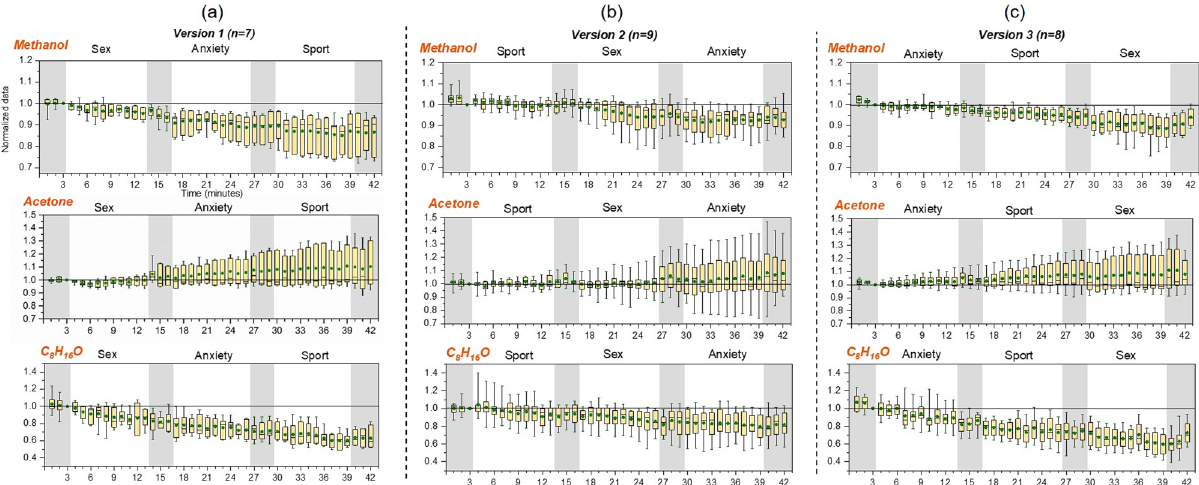
Figure 1. Time series of methanol, acetone and C 8 H 16 O (normalized to the 3rd minute of the first neutral clip based on mixing ratio data) under three film clip playing orders: ( a ) version 1 (sex–anxiety–sport) including 7 participants (male: 4, female: 3); ( b ) version 2 (sport–sex–anxiety) including 9 participants (male: 5, female: 4); version ( c ) (anxiety–sport–sex) including 8 participants (male: 3, female: 5). Shaded area represent the time when neural clips were played. The boxes represent 25% to 75% of the dataset, with the circle and central line indicting the mean and median values, respectively. The whiskers indicate the minimum and maximum data points. The horizontal solid line in each sub-plot represents the value at 1.0 as a reference.